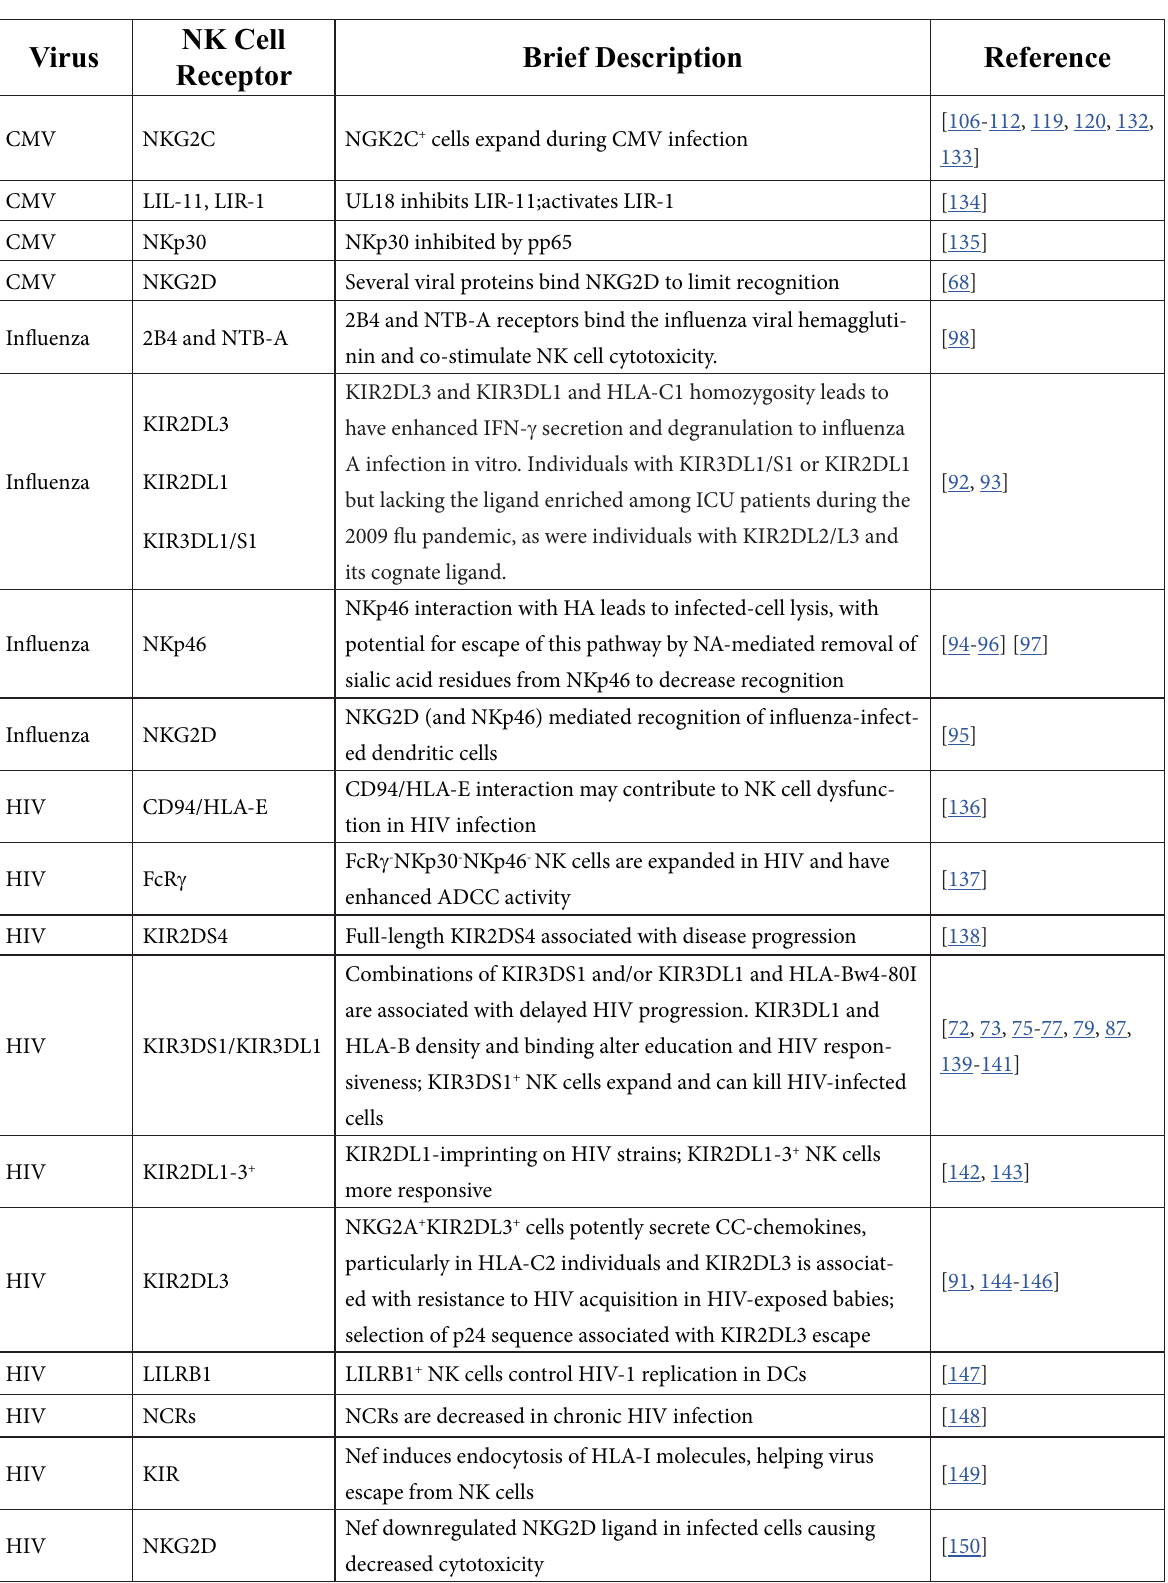
Table 1. NK cell receptor virus interactions NK Cell Virus